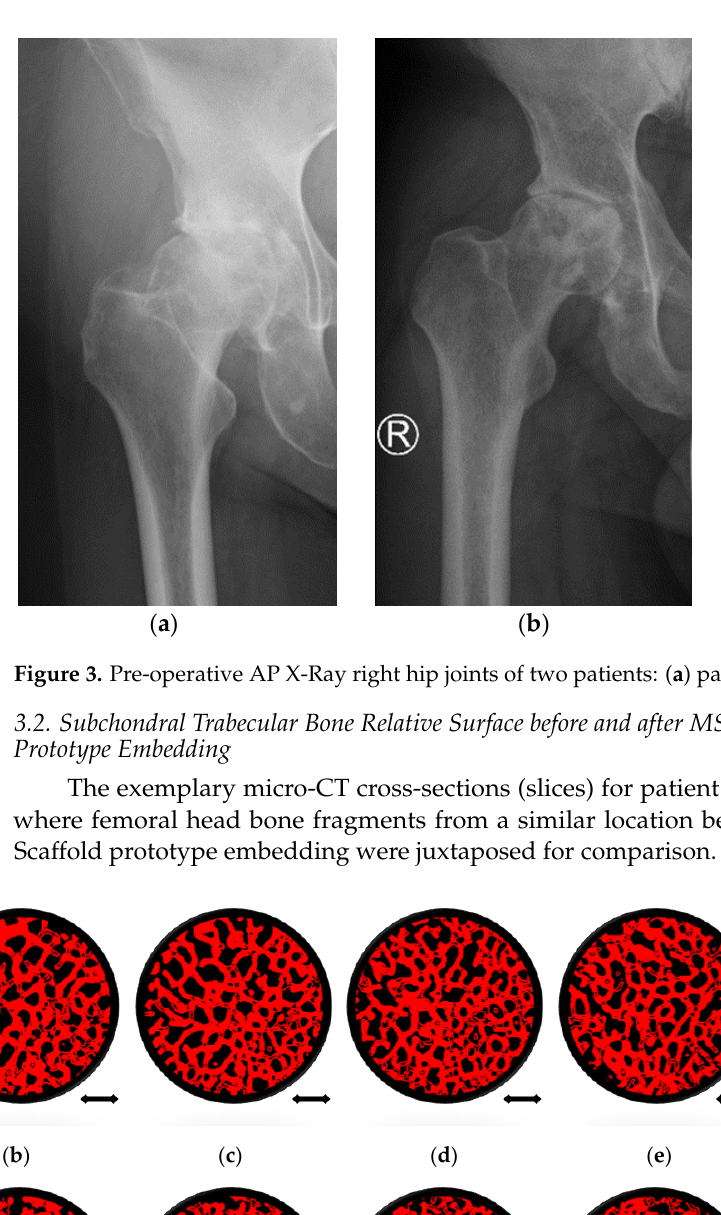
Figure 3. Pre-operative AP X-Ray right hip joints of two patients: ( a ) patient 2; ( b ) patient 4.